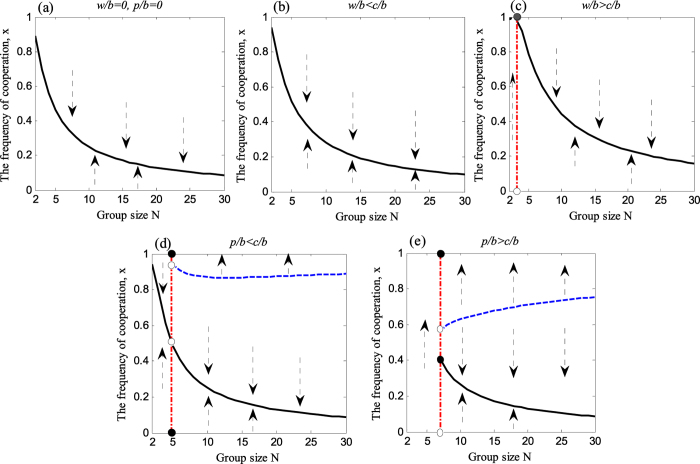
Stationary fraction of cooperation.It is shown that the stable equilibrium  (thick lines) and unstable equilibrium  (dotted lines) as a function of group size N for different values of reward-to-benefit ratio w/b and punishment-to-benefit ratio p/b. Between these equilibria, the fraction of cooperator either increases or decreases as a result of the evolutionary dynamics, which is indicated by arrows here. (a) Even without rewarding and punishing, a stable equilibrium exists for a small cost-to-benefit ratio, c/b. However, the fraction of cooperators drops with the increase of cost-to-benefit ratio, c/b. (b,c) show when the reward ratio increases, a stable state of full cooperation emerges for small group size80. (d) Considering the punishment in this game (namely, instead of the reward mechanism), besides the interior equilibrium, the boundary equilibrium is also stable. A stable state of full cooperation (ALLC state) emerges for large group size when p/b < c/b, (e) while ALLC state emerges for any group size when p/b > c/b. Parameters: c/b = 0.2; (a) w/b = 0, p/b = 0; (b) w/b = 0.1, p/b = 0; (c) w/b = 0.5, p/b = 0; (d) w/b = 0, p/b = 0.1; (e) w/b = 0, p/b = 0.5.